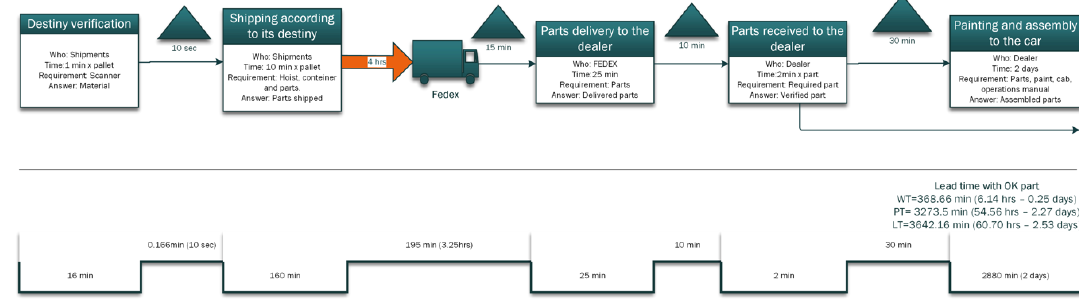
Figure 22. The fourth part of four of the future state map is displayed. Finally, a proposal A3 report was made. The goal of the proposal A3 is to present a logical, structured plan for consideration so that a good decision on implementation can be made [39]. Figure 23 shows the result of the proposal A3 report. In Figure 23, ‘Nombre del Proyecto’ stands for ‘Name of the P roject’, and ‘Objetivo y Alcance ’ stands for ‘Aim and Scope’. Figure 23. Proposal A3 Report. 6. Discussion of Results